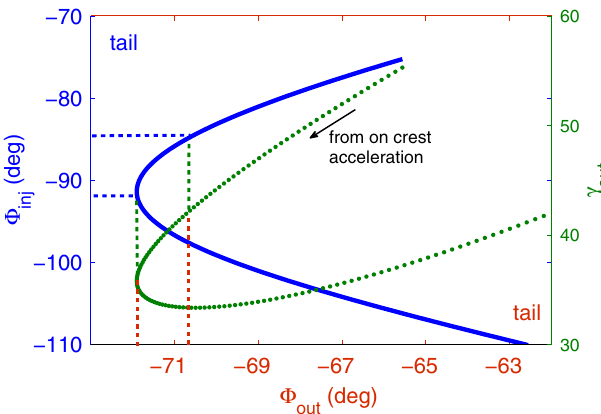
FIG. 7. Analytical solution of the single particle longitudinal equations of motion along a TW cavity. The blue solid curve shows the relation between injection and extraction phase. The green dashed curve represents the normalized energy as function of extraction phase, i.e., the curvature of the output LPS. By selecting an injection phase interval and doing its projection on the x axis via the blue curve, one can find the output phase interval. The intersection with the green curve gives the shape of the LPS. The lines plotted as an example are significative of the measured LPS reported in Fig.